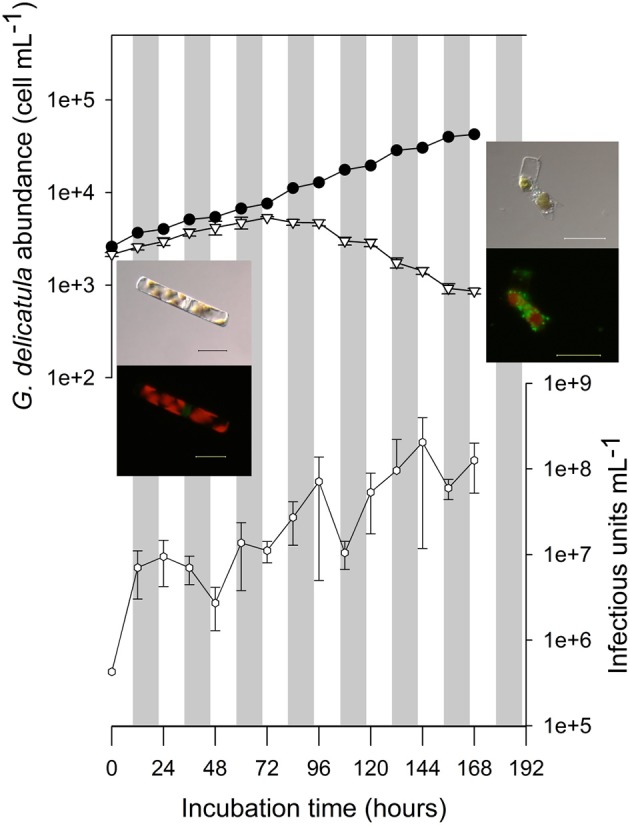
Infection kinetic of Guinardia delicatula RCC3083 by GdelRNAV-01. Abundances of diatom hosts in the control culture (black circles) and in infected cultures (open triangles) were obtained using optical microscopy. Viral titers (open hexagons) were estimated using the MPN method. Error bars were estimated based on counts obtained in triplicates of infected cultures. Gray rectangles represent the dark phases. Pictures obtained using transmitted-light and epifluorescence microscopy illustrate the morphology of G. delicatula cells in control and infected cultures at T0 and Tfinal. With epifluorescence microscopy the red natural fluorescence of chloroplasts and green fluorescence of PicoGreen stained nucleic acids are observed. At Tfinal, the green fluorescence is due to the presence of bacteria. Scale bars: 20 μm.